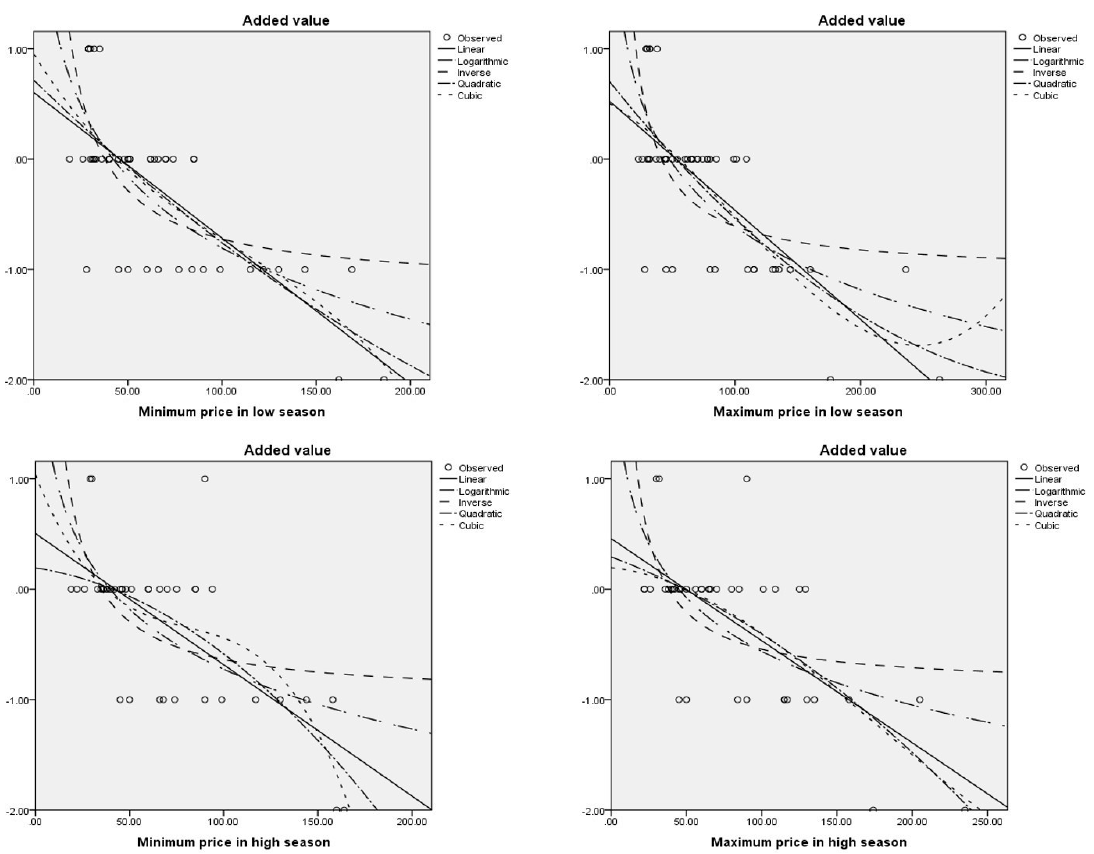
Figure 4. Functions of the regression analysis with the best fit in the Agadir destination.